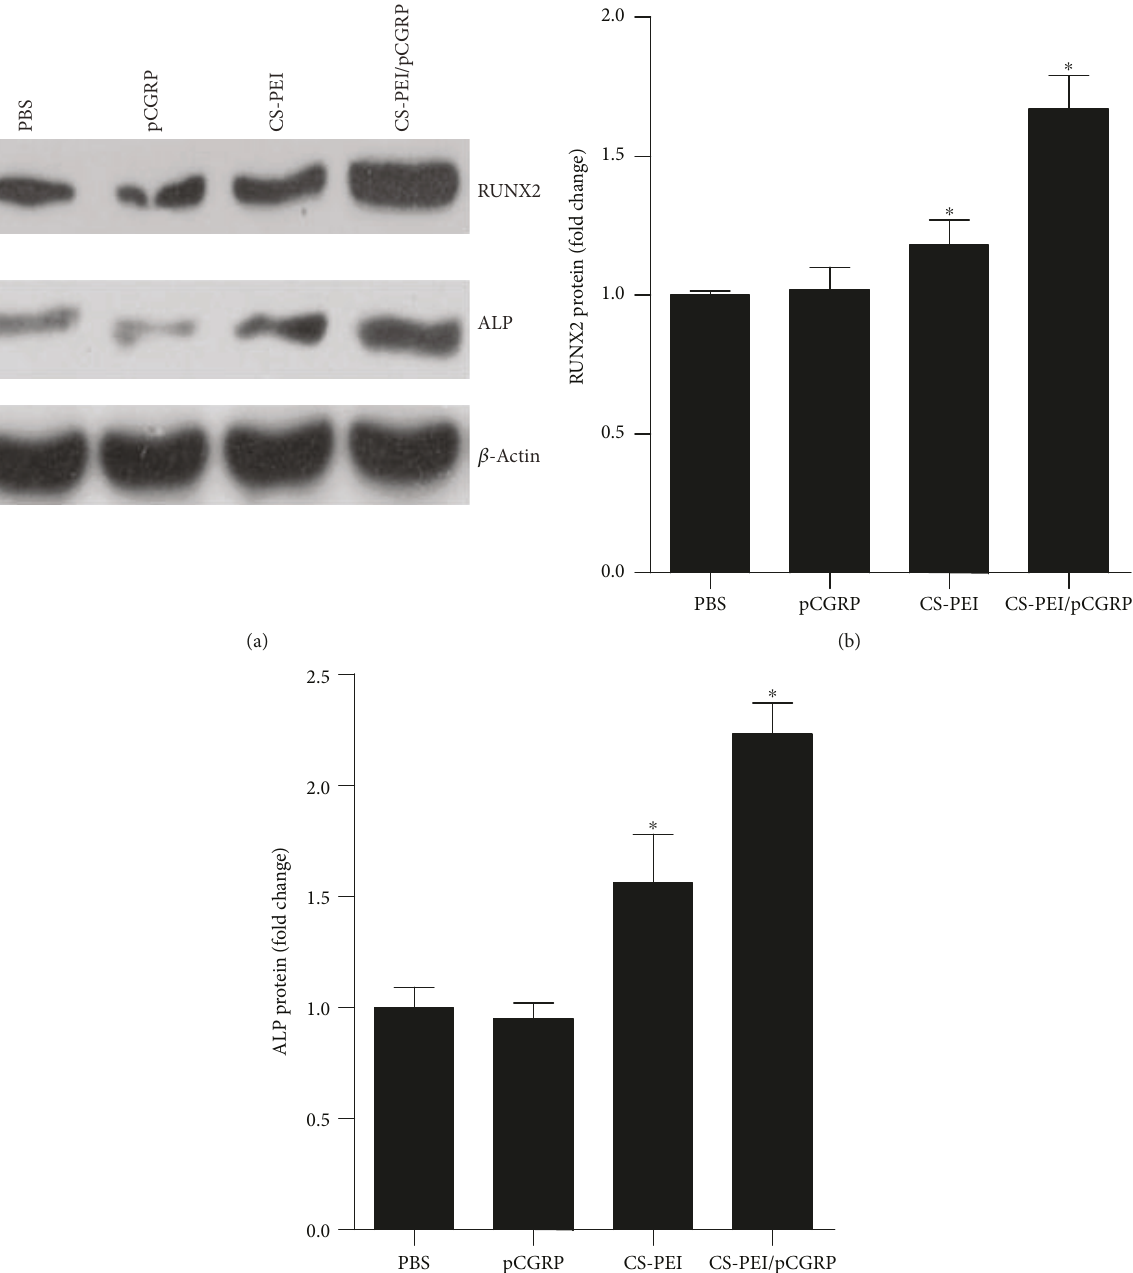
Figure 9: RUNX2 and ALP protein levels in callus of rat femoral fracture model after a 3-week treatment with CS-PEI/pCGRP. Data are mean ± standard deviation ( n = 4 ). ∗ P < 0 05 vs. the PBS